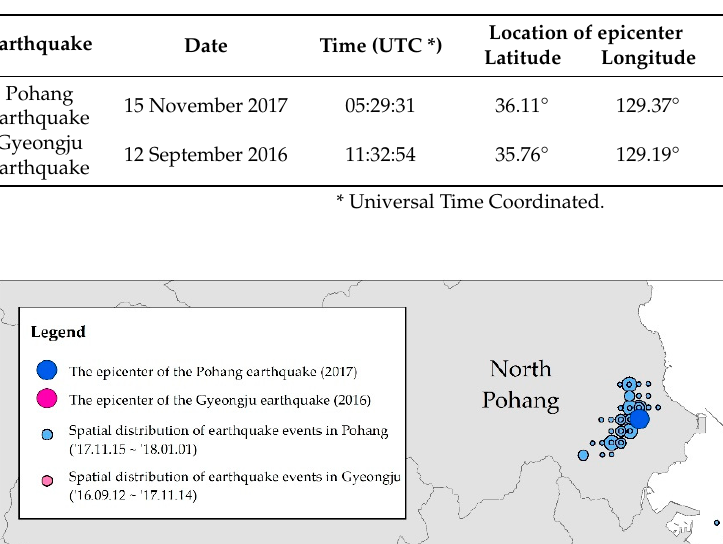
Table 1. The Pohang earthquake and the Gyeongju earthquake [1].